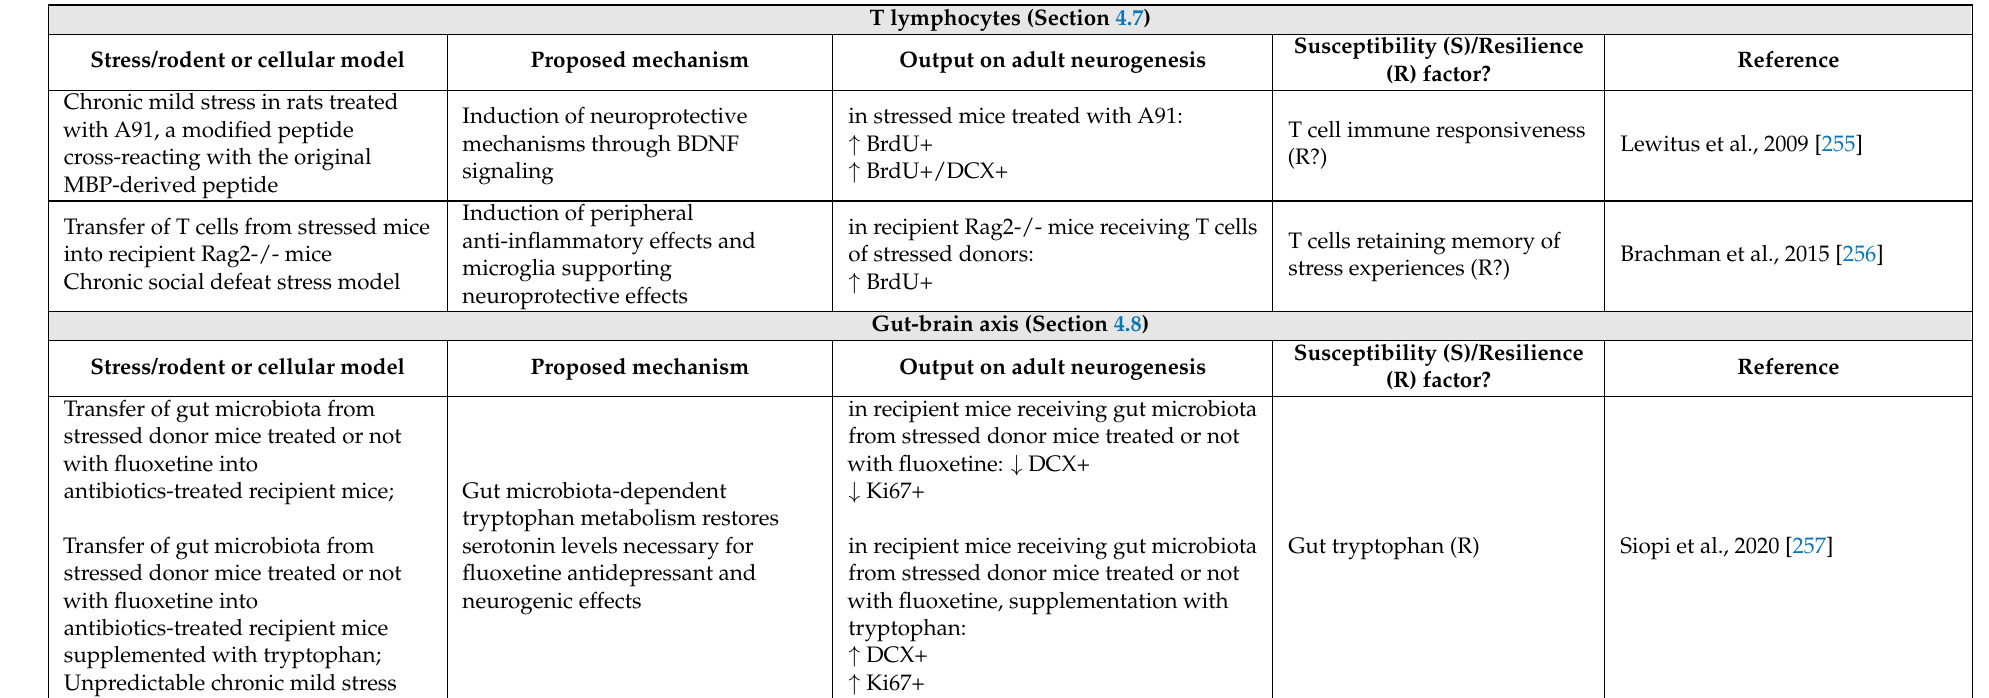
Table 2. Cont . T lymphocytes (Section